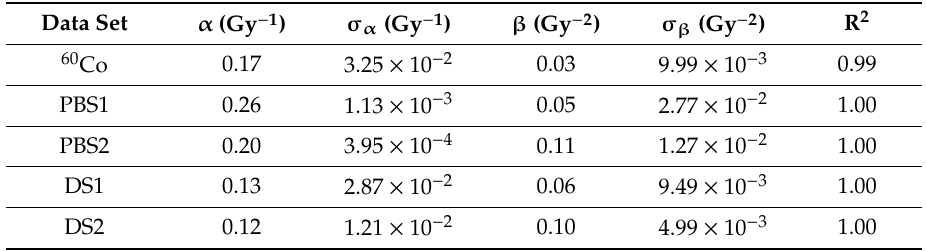
Table 4. The parameters of the Linear-Quadratic (LQ) model ( α , β ), their standard errors ( σ α , σ β ), and the correlation parameter R 2 .